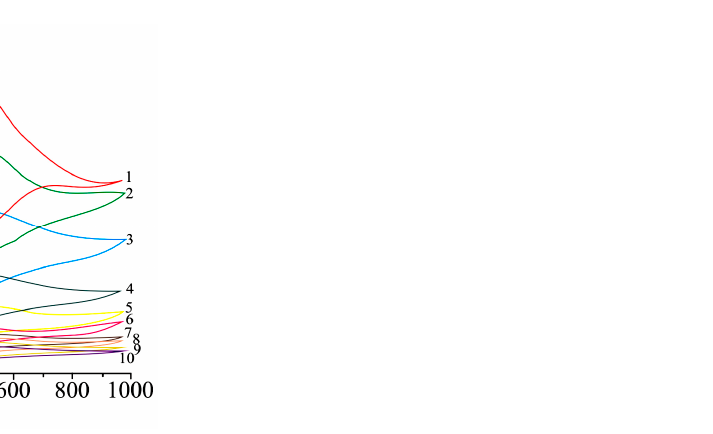
Figure 1. Cyclic voltammograms obtained at a carbon paste working electrode at varying ascorbic acid concentrations, as mM: 20 (1), 15 (2), 10 (3), 5 (4), 2.5 (5), 1.25 (6), 0.625 (7), 0.31 (8), 0.15 (9), and 0.07 (10); potential scan rate 50 mV/s [123].